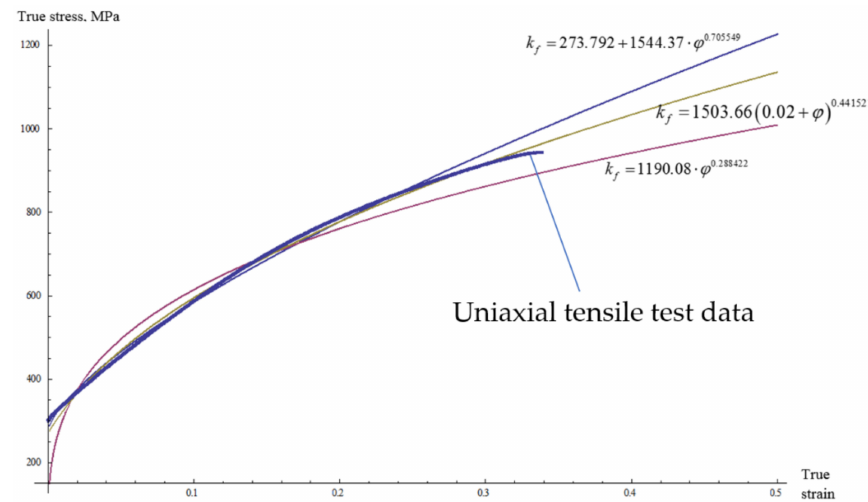
Figure 11. Comparison of measured data and mathematical models.